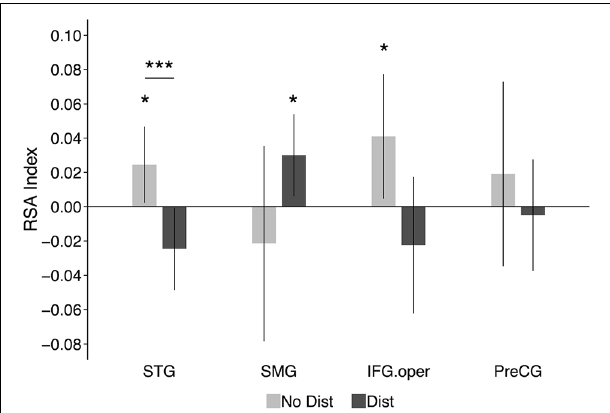
FIGURE 4 | RSA results in functional ROIs defined based on results from Yue et al. (2019): the left STG, the left SMG, the left IFG.oper, and the left PreCG. The graphs show the average neural-model similarity index (i.e., Spearman correlation coefficient) during the delay period. Error bars represent 95% within-subjects confidence intervals around the mean. No Dist, no-distractor condition; Dist, distractor condition. STG, superior temporal gyrus; SMG, supramarginal gyrus; IFG.oper, inferior frontal gyrus (the opercular part); PreCG, precentral gyrus; * p < 0.05; *** p <